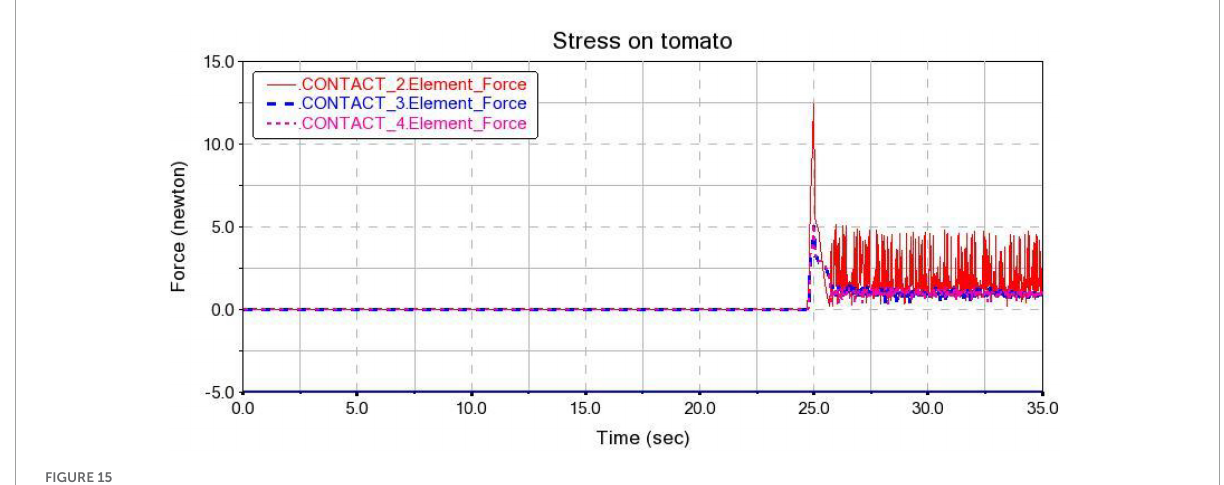
FIGURE15 The force of tomato with a diameter of 80